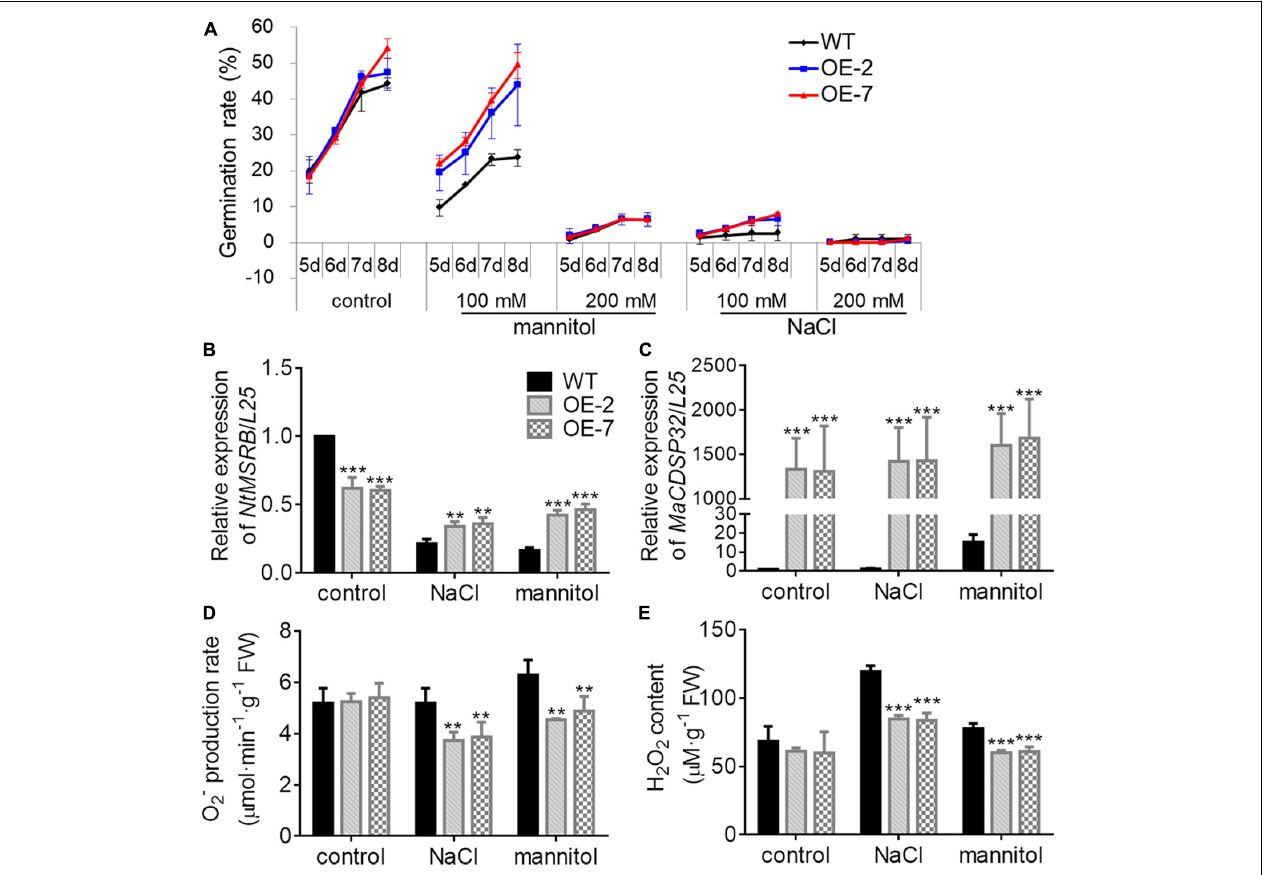
FIGURE 7 | Overexpression of MaCDSP32 enhances seed germination in transgenic tobacco under osmotic stress. (A) Seed germination rates after sowing at 5, 6, 7, and 8 days of treatment with mannitol or NaCl at various concentrations (100 mM and 200 mM). (B,C) Relative gene expression of NtMSRB (B) and MaCDSP32 (C) in germinating seeds after 6 days of treatment with 100 mM NaCl or mannitol. (D,E) Production of O 2 − (D) and H 2 O 2 (E) after 6 days of treatment with 100 mM NaCl or mannitol. At least three biological replicates were included. Asterisks indicate significant differences between the transgenic and WT lines ( t -test, ** P < 0.01, *** P <